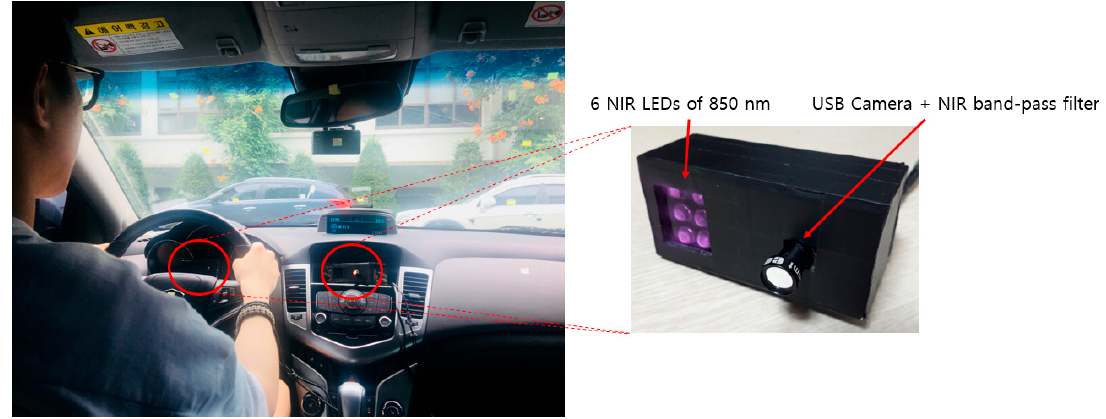
Figure 2. Experimental setup in the vehicle environment.